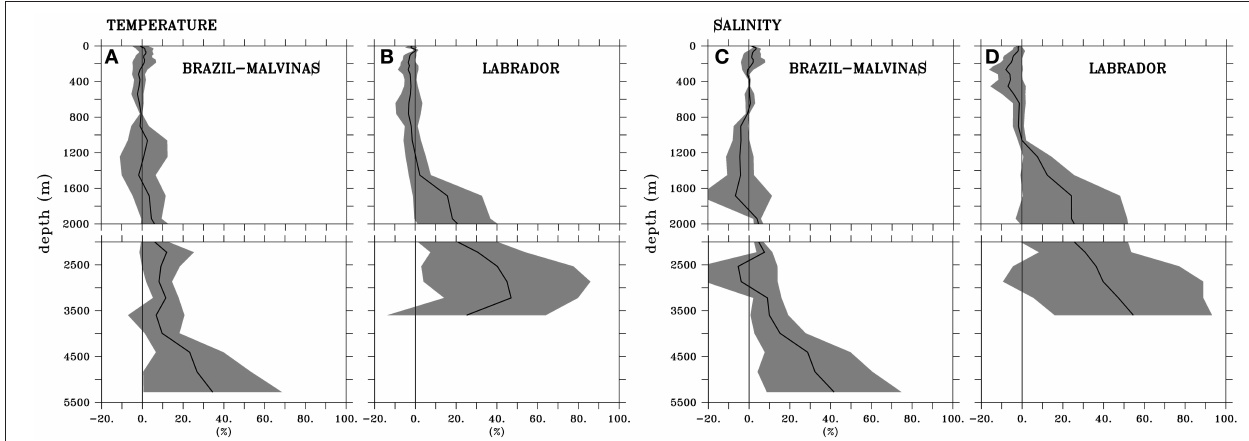
FIGURE 6 | Evaluation of the deep Argo array which samples to the 6,000m in H2020 AtlantOS. Showing RMS error reduction of temperature and salinity in 0–6,000m in the OSSE for the design of the deep Argo array, as compared with the OSSE for the reference design, area-averaged in the Brazil-Malvinas confluence (30–51 ◦ S, 15–70 ◦ W) (A,C) and in the Labrador Sea (B,D) . The black line is the ensemble mean. Gray indicates the standard deviation of the four members (CMCC, CLS, Mercator Ocean, and UKMO). Unit is percent of error reduction, compared to the OSSE for the reference